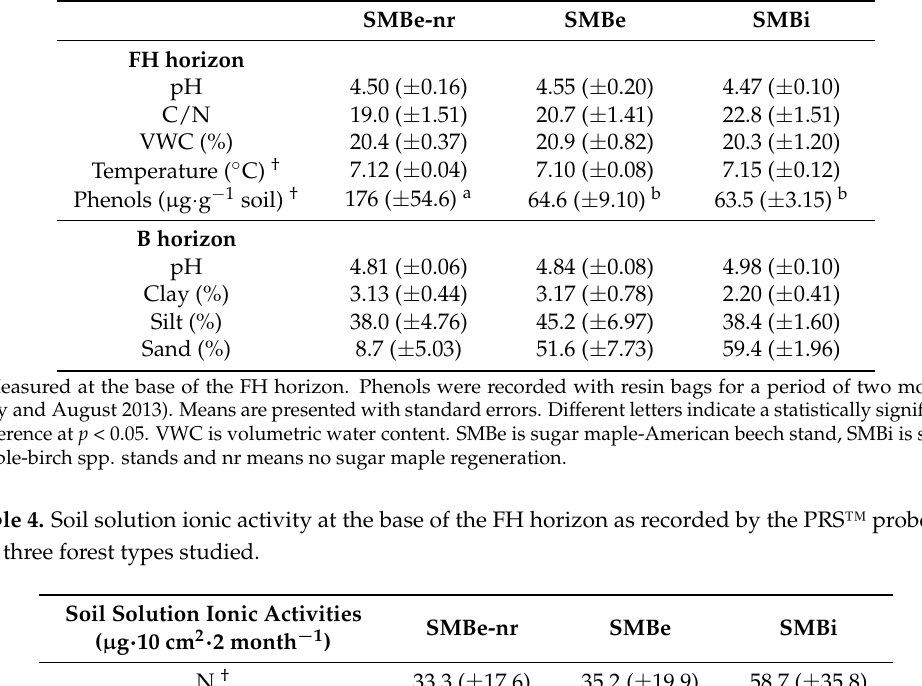
Table 3. Physicochemical characteristics of the FH and B horizons in the three forest types studied.